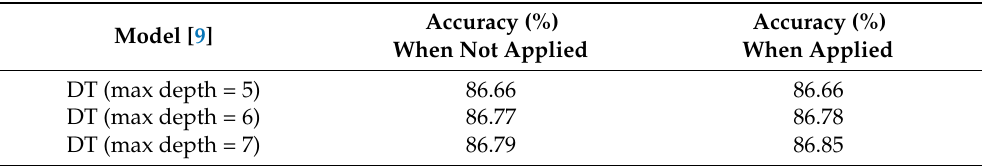
Figure 4. Heatmaps of the correlations between the features and binary class using the Pearson correlation coefficient ( a ) before and ( b ) after data augmentation. Table 3. Effectiveness of data augmentation techniques in the basic machine learning (ML) model with decision tree (DT) models (max_depth = maximum tree